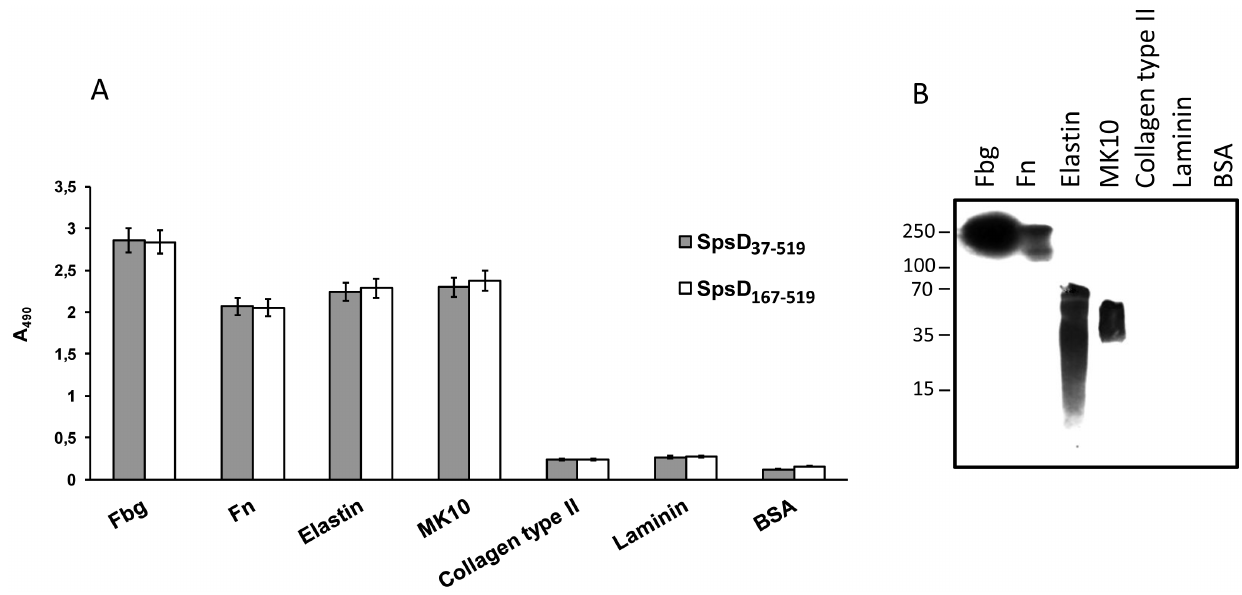
Figure 2. Binding of SpsD proteins to extracellular matrix or plasma proteins. (A), ligands were coated onto the surface of microtiter plates (1 m g/well) and incubated with 17.5 nanomoles of SpsD 37–519 or SpsD 167–519 , followed by mouse anti-His IgG and HRP-conjugated rabbit anti-mouse IgG. A , absorbance. (B), purified, unreduced human Fbg, Fn, a -elastin, mouse K10, collagen type II, laminin and BSA were subjected to SDS-PAGE, transferred to nitrocellulose filter and then incubated with SpsD 167–519 , followed by incubation with mouse anti-SpsD 37–519 and HRP-conjugated rabbit anti-mouse antibodies. Molecular mass markers are indicated (kilodaltons).